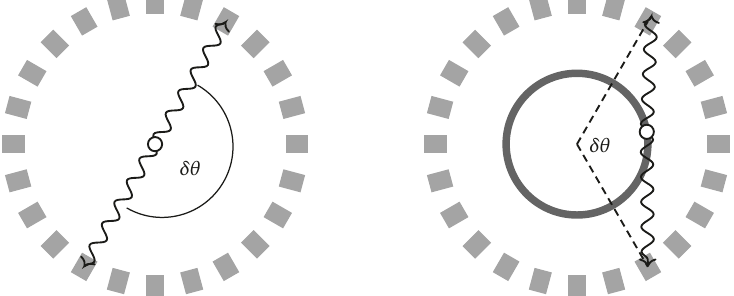
Figure 8: Explanation of the broadening of the 2 𝛾 annihilation band present in Figures 7(a) and 7(b) at 𝛿𝜃 2 + 𝛿𝜃 3 ≈ 180 ∘ . Left: when 2𝛾 annihilations originate in a small region in the detector center, the calculated relative azimuthal angles of detection modules which registered the photons correspond closely to actual relative angles between photons’ momenta. Right: with 2𝛾 annihilations taking place in the walls of an extensive-size annihilation chamber (gray band), the broadening of the band at 180 ∘ is caused by a discrepancy between the calculated and actual relative angles. The detector scheme and proportions are not preserved for